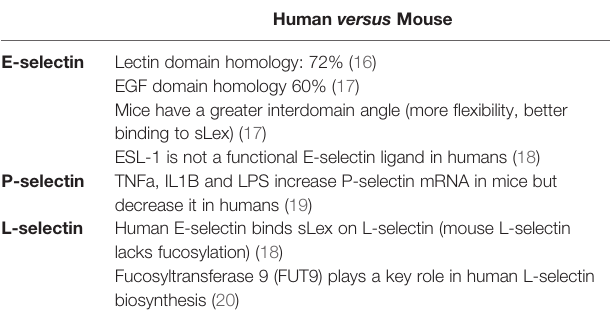
TABLE 1 | Differences between mouse and human selectins. Human versus